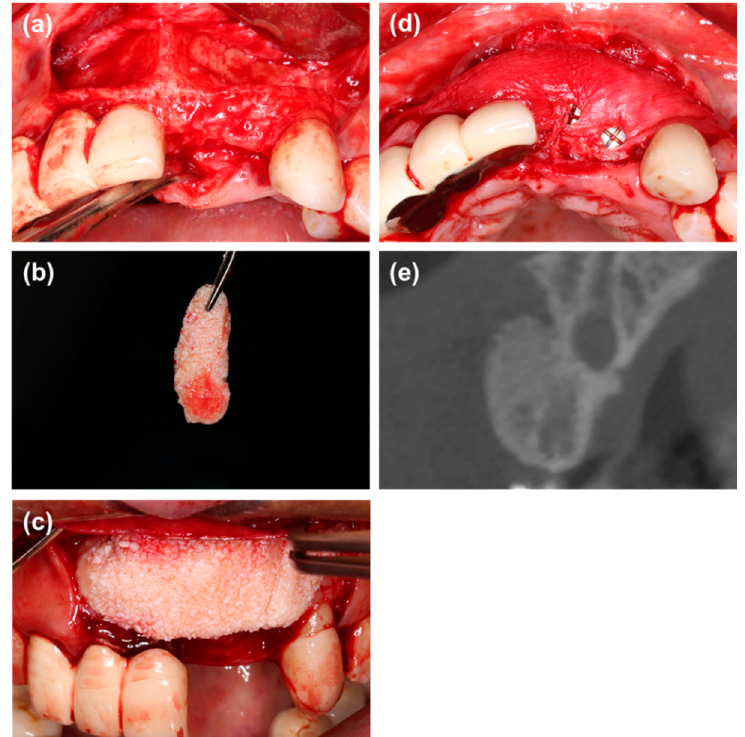
Figure 3. ( a ) The labial defect could be observed. ( b ) Particulate bone substitutes were mixed with i-PRF to form sticky bone. ( c , d ) The sticky bone was placed into the bone defect and covered with a collagen membrane, and titanium pins were used to fixate the membrane. ( e ) Radiographic view of cone beam CT immediately after wound closure.